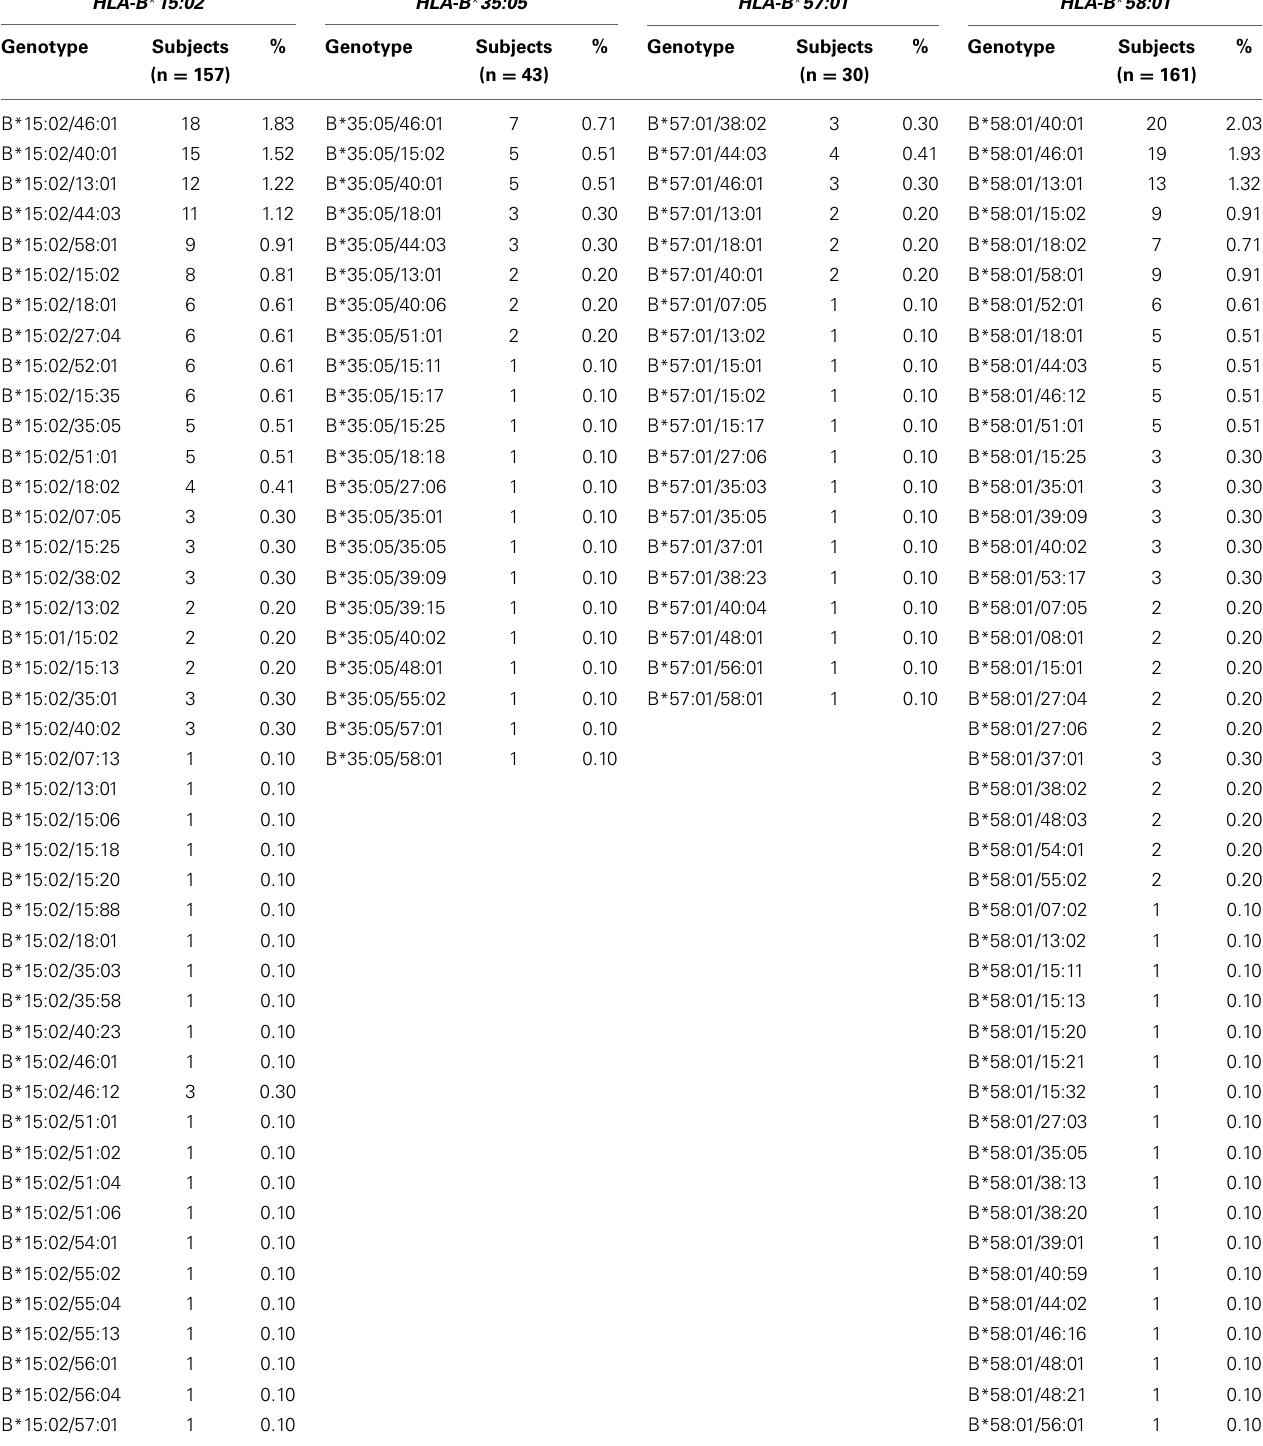
Table 3 | Pharmacogenomics markers of HLA-B genotype in a Thai population (n = 986). HLA-B *